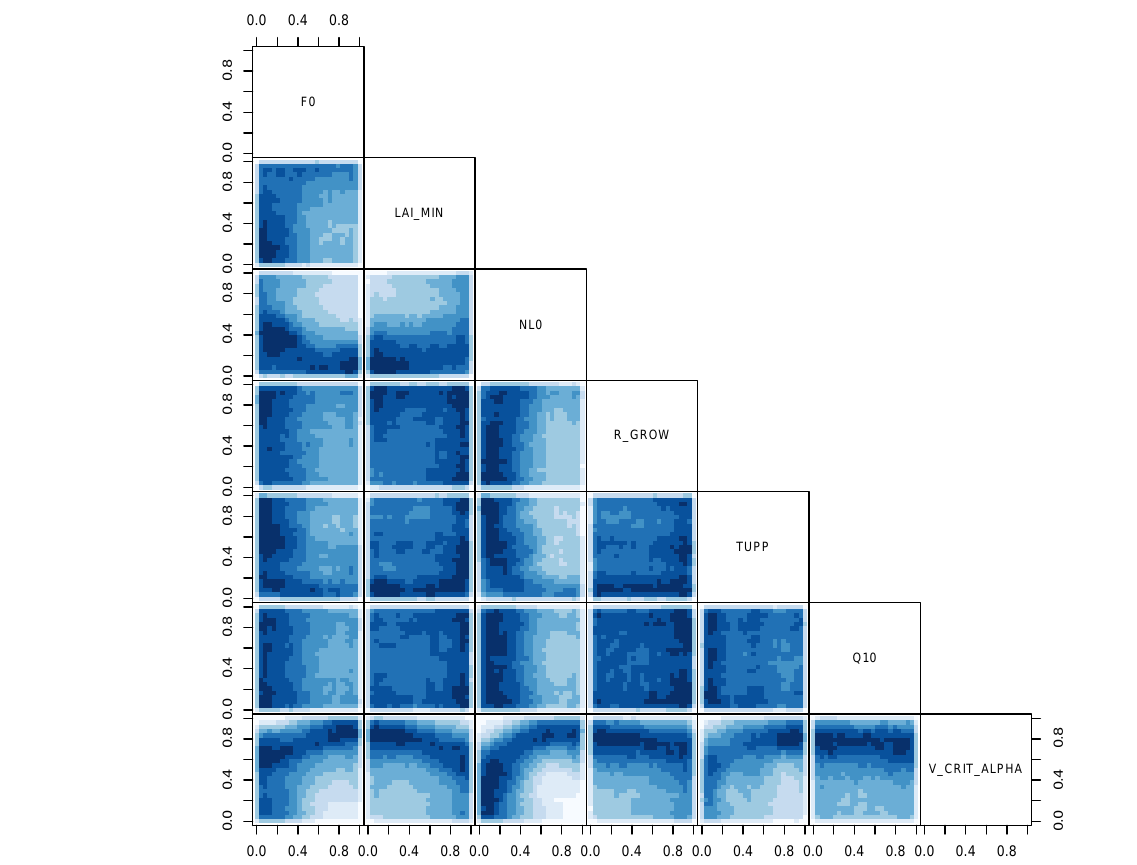
Figure 14. A density plot of the two-dimensional projections of NROY samples from the design input space, using all forest observations and a discrepancy function for the